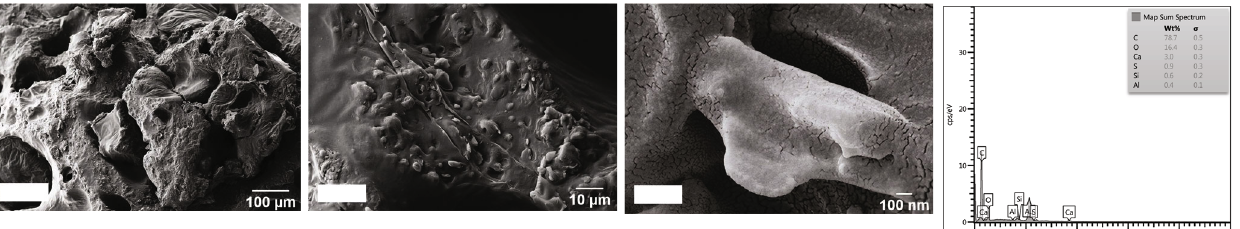
Figure 15: SEM images and energy-dispersive spectroscopy (EDS) analysis of PURFs PU-S4.